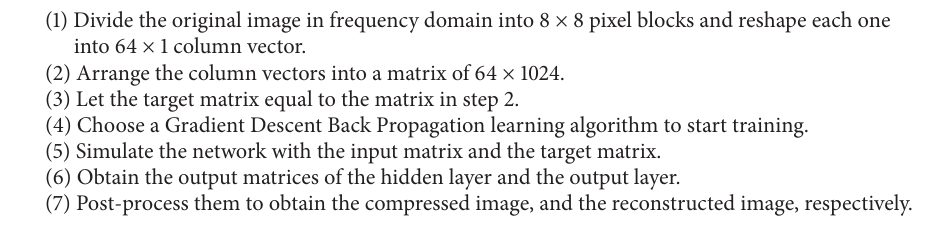
Algorithm 1: Image compression and decompression using